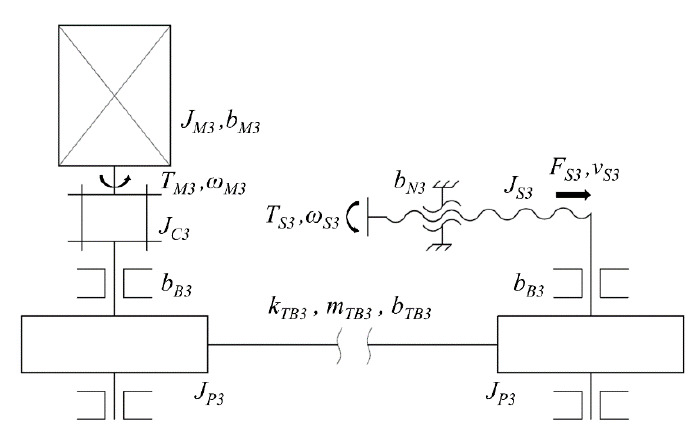
Figure 3. General schematic of the linear drive system with a toothed belt.